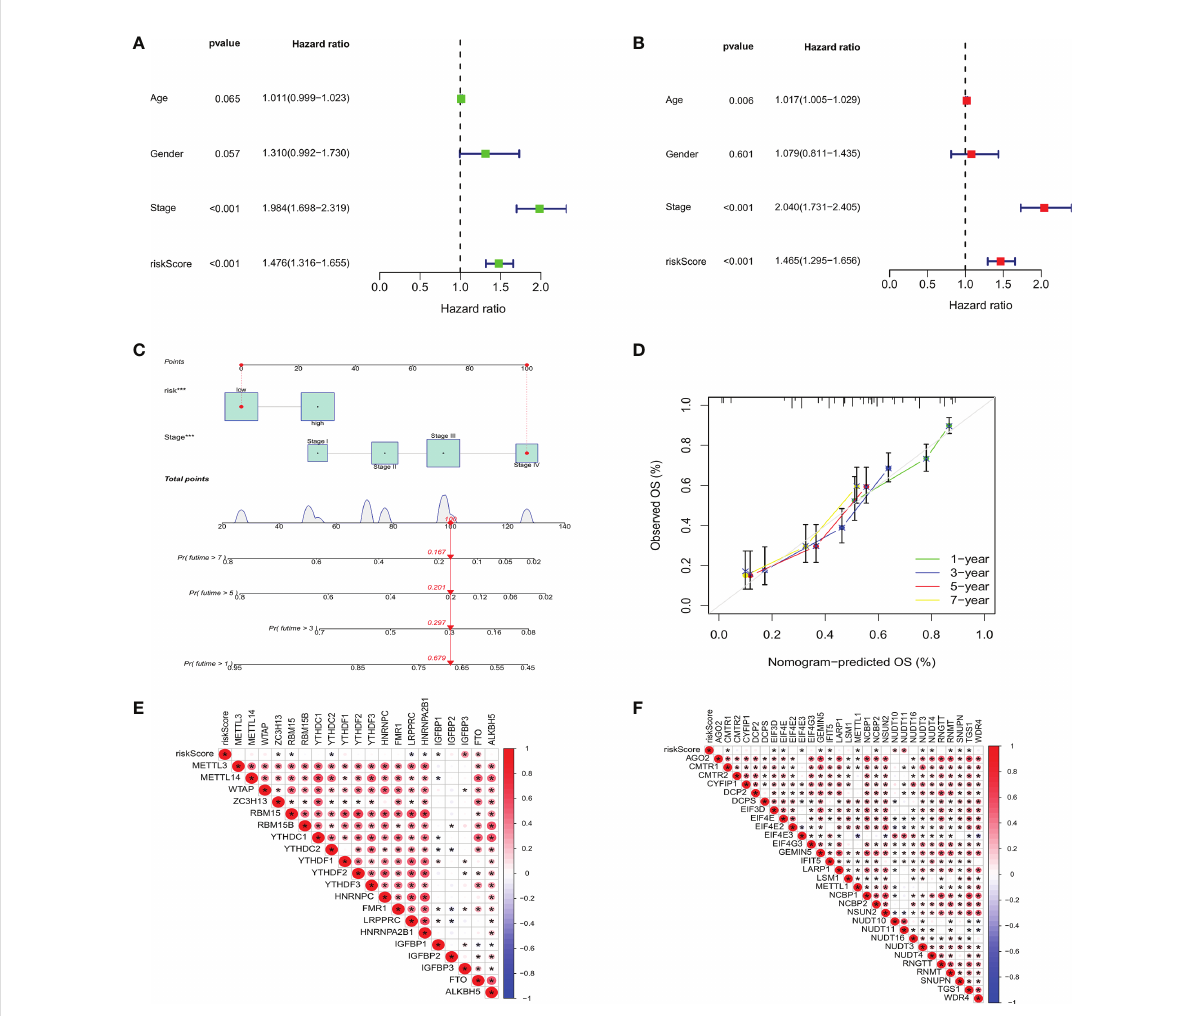
FIGURE 9 Based on univariate (A) and multivariate Cox analysis (B) , m7GRG_Score was determined to be an independent prognostic factor for GC patients. (C) nomogram for predicting 1 -, 3 -, 5-and 7-year OS in GC patients. (D) Calibration curves for nomogram with predicted 1-, 3-, 5-, and 7-year OS. Correlation analysis of m6A (E) and m7G (F) related genes with m7GRG _Score. *P <